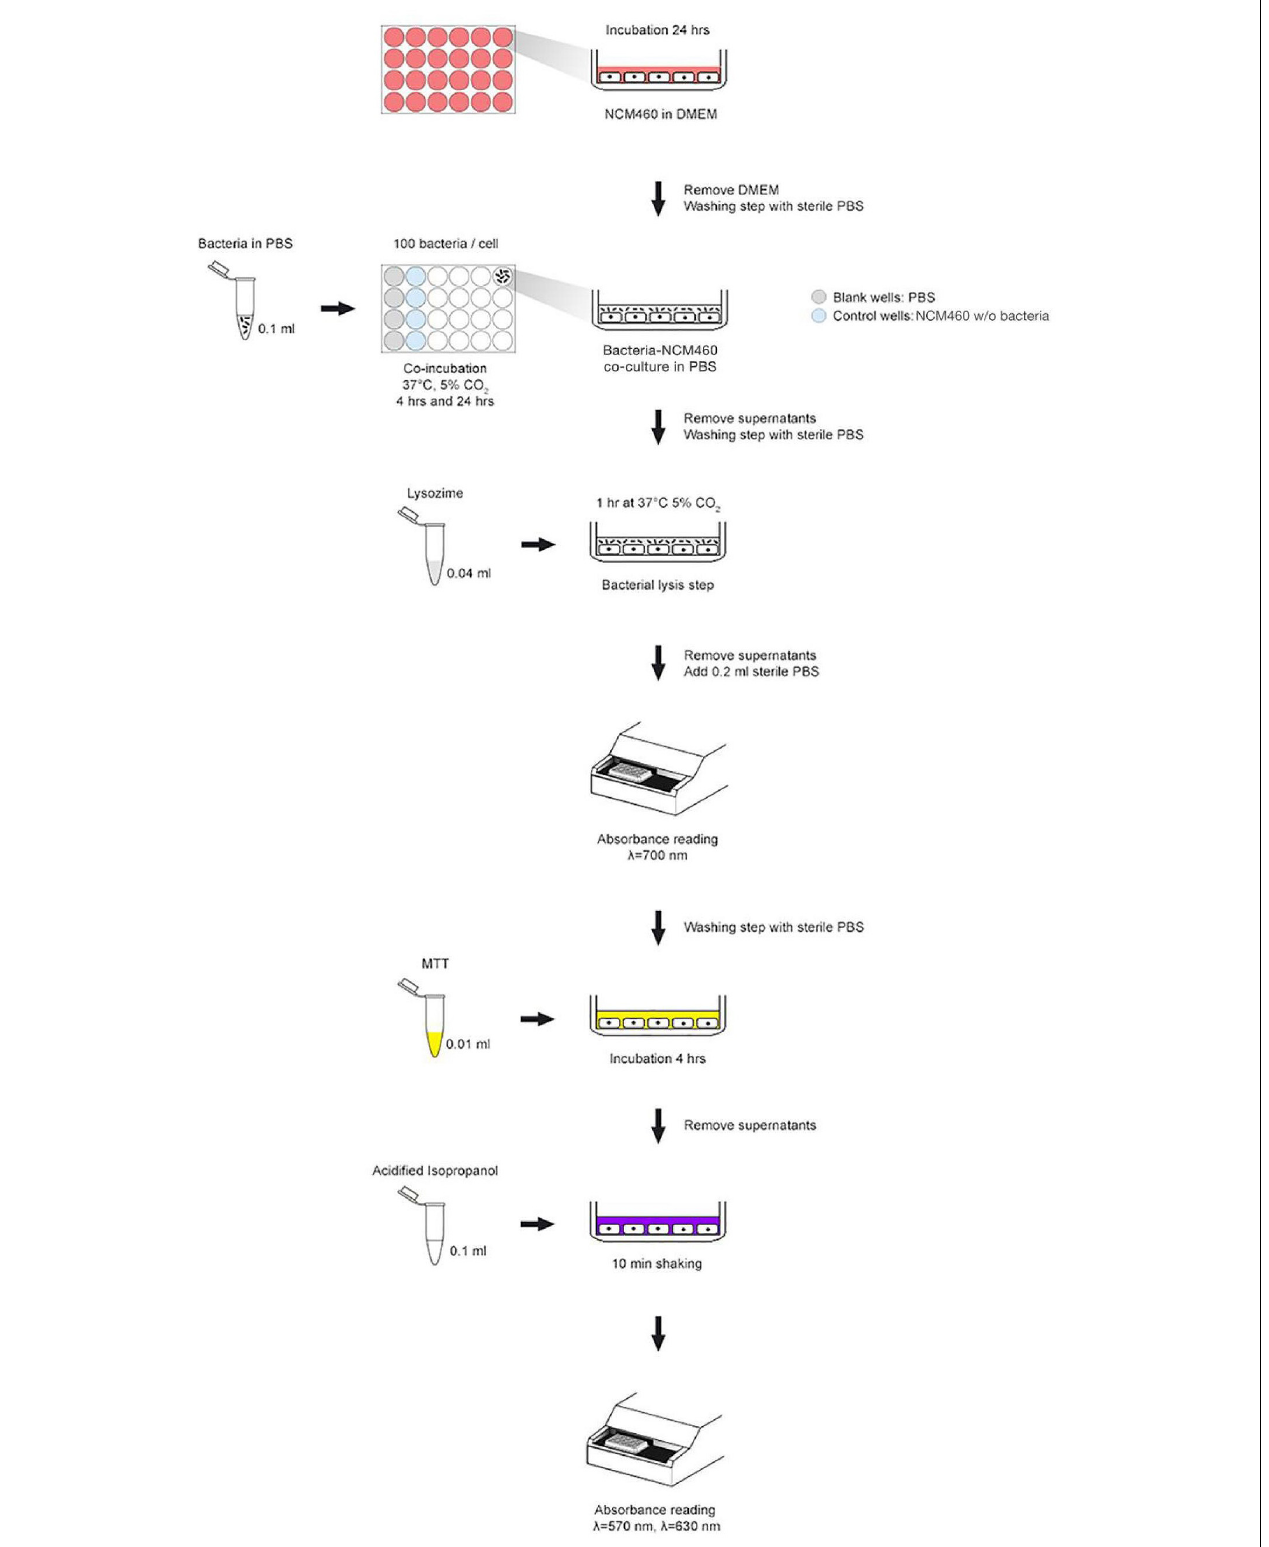
FIGURE 1 | MTT experimental scheme used to assess cell metabolic activity in co-incubation assays.